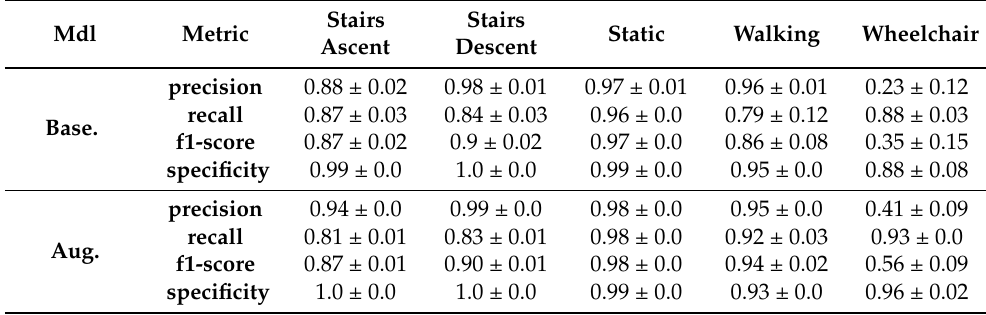
Table A5. Single class results of the baseline and augmented model for the real-life test set. Considered data: WPS holdout participants.